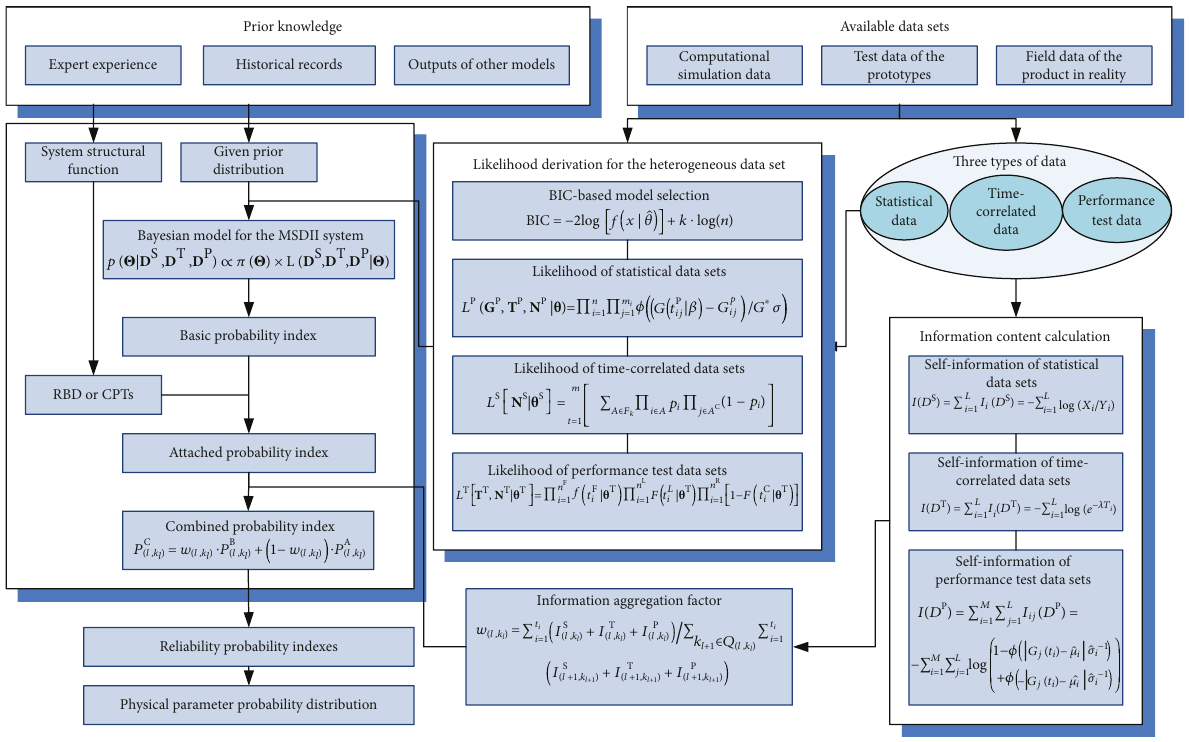
Figure 8: Reliability framework for the case study. Table 6: Calculation and selection of the likelihood function.